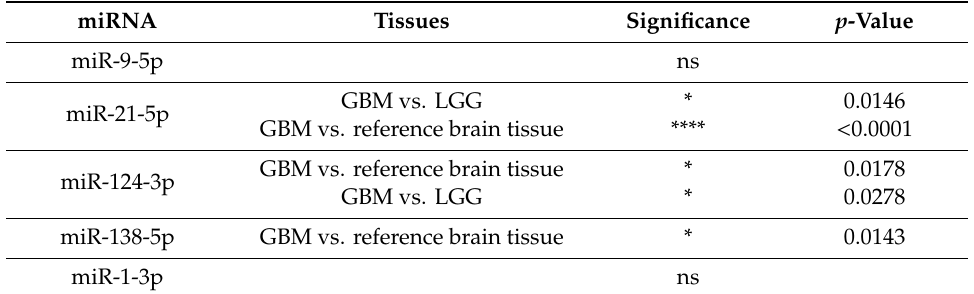
Figure 2. Relative expression levels of miRNA in glioblastoma, LGG, and reference brain tissues. * p < 0.05, and **** p < 0.0001. Results are presented as mean, and standard deviation as error bars. LGG—lower-grade glioma. Table 3. Statistical analysis of the qPCR results of miRNA expression in GBM, LGG, and reference brain tissue